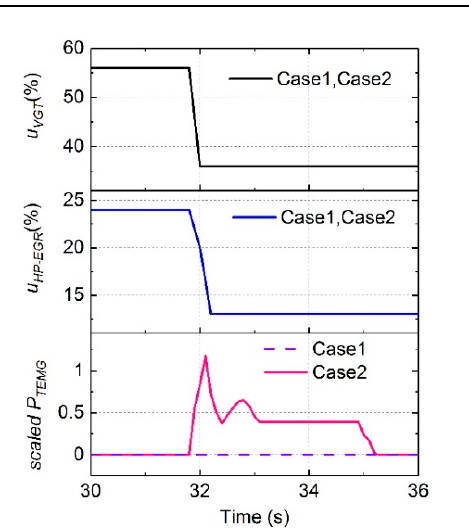
Figure 9. Regulations of three actuators during the transient process.